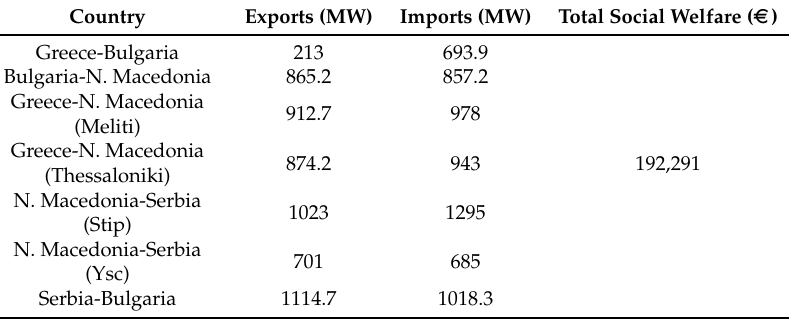
Table 5. Cross-border flows via the FB method for the 4 country